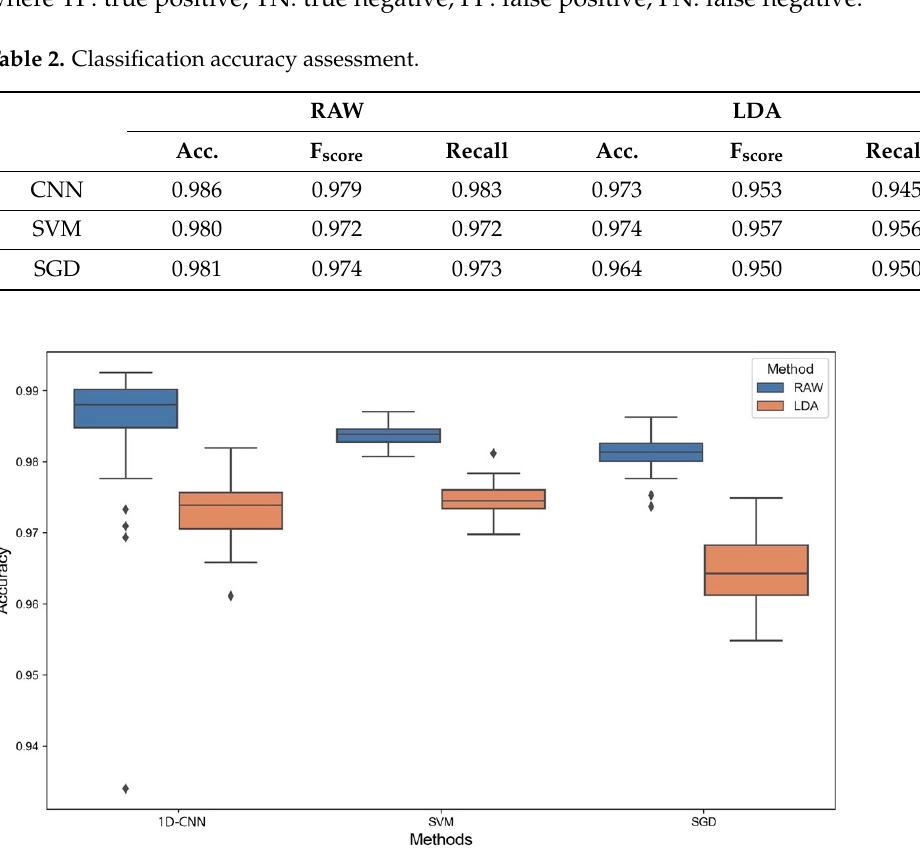
Figure 6. Box and whisker plot of classification accuracy scores for three algorithms. One dimensional convolutional neural network (1D-CNN), support vector machine (SVM) and stochastic gradient descent (SGD).